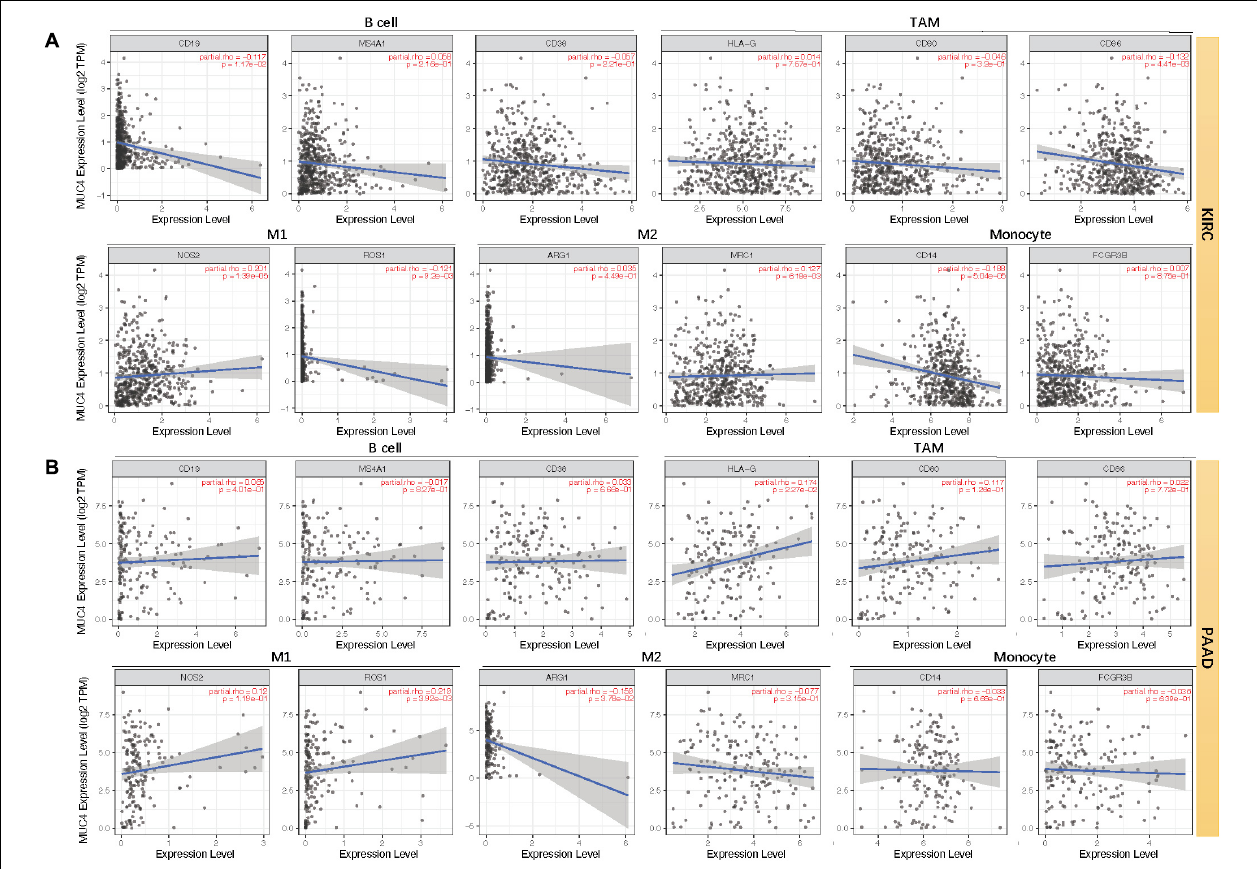
FIGURE 6 | Correlation between mRNA expression of MUC4 and immune markers of KIRC (A) and PAAD (B) in TIMER2.0. TAM, tumor-associated macrophages; M1, type-1 macrophage; M2, type-2